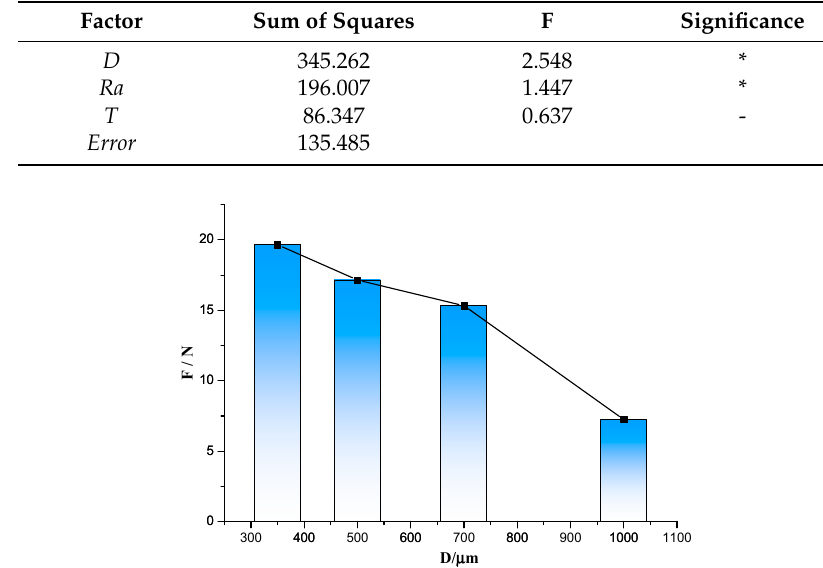
Table 3. Significance analysis of the influence of orthogonal experimental factors.